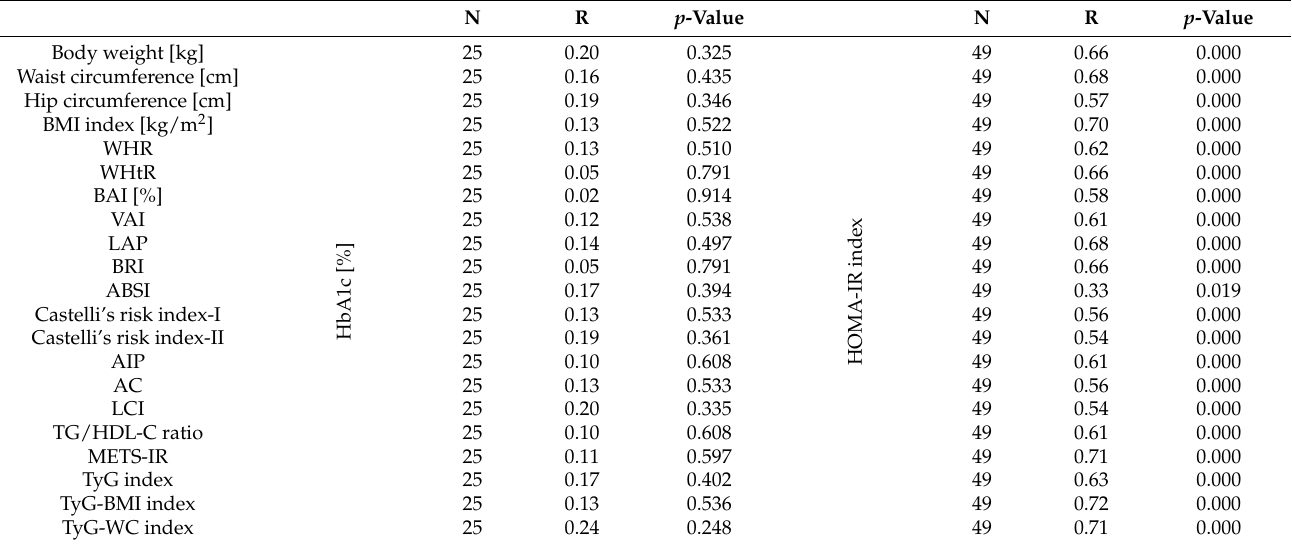
Table 4. Correlations between anthropometric parameters, atherogenic indices and HbA1c and HOMA-IR index in the study